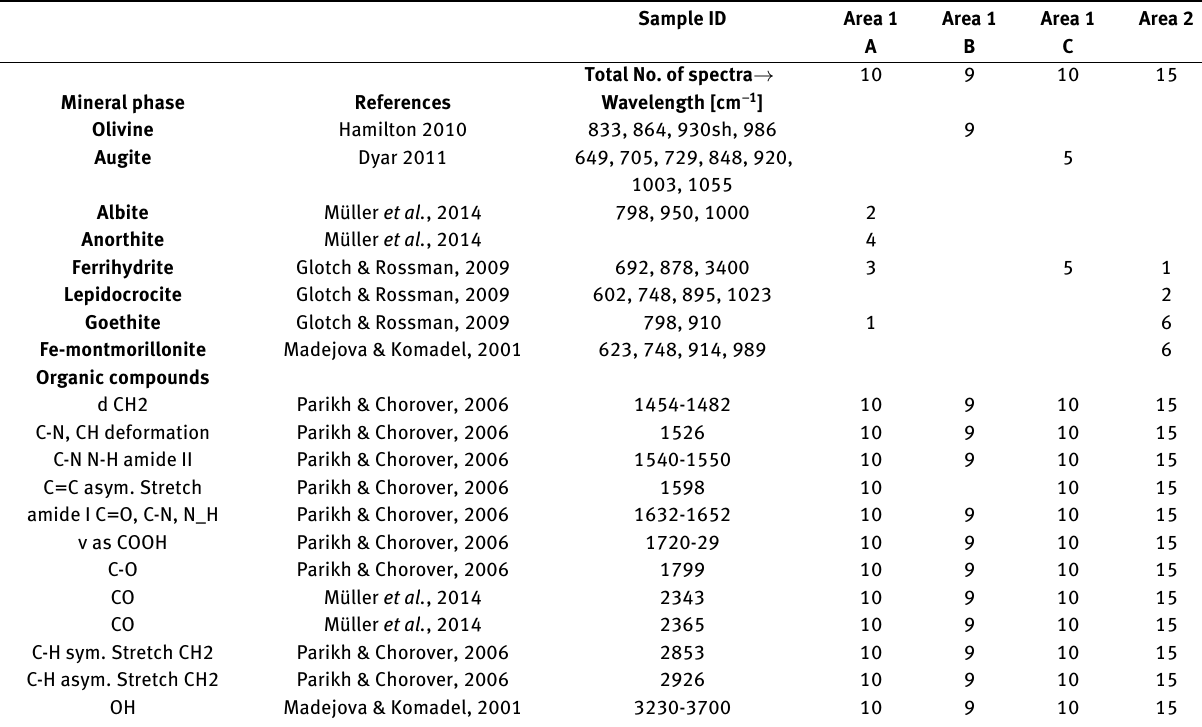
Table 2. Distribution of mineral and organic matter composition in Mócs meteorite determined by FTIR-ATR